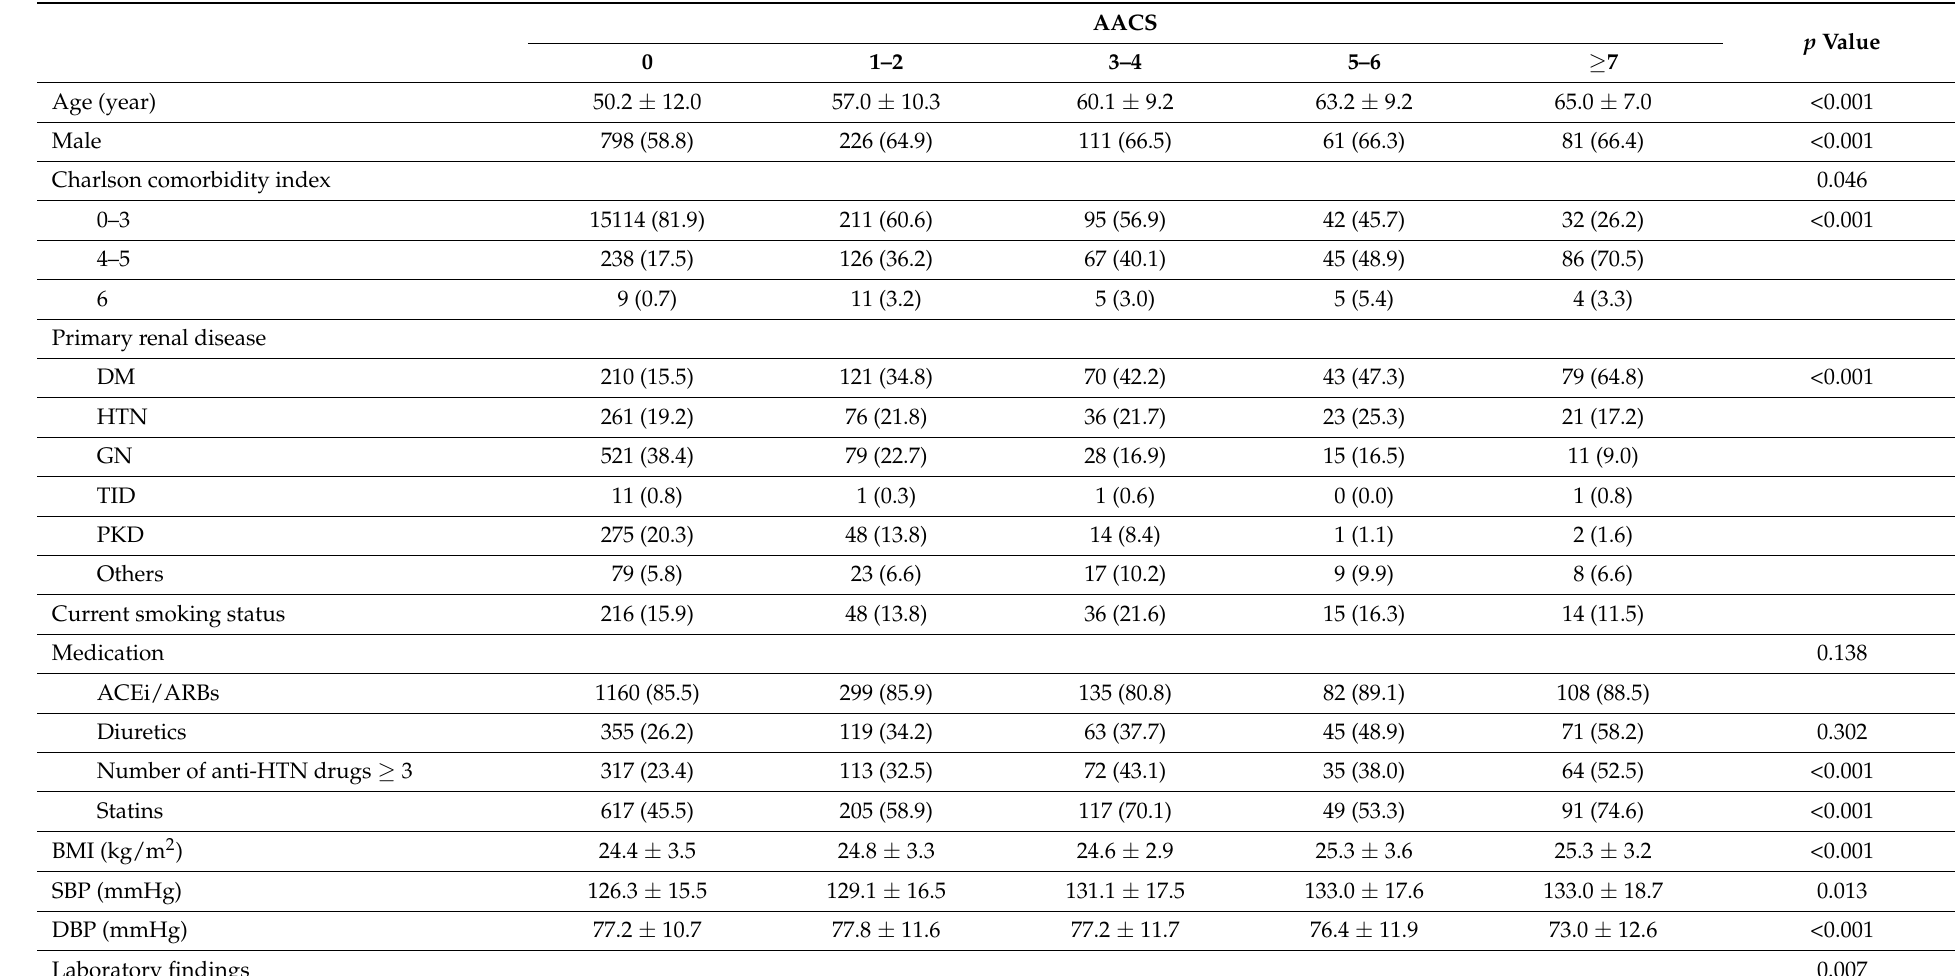
Table 1. Baseline characteristics of study participants by